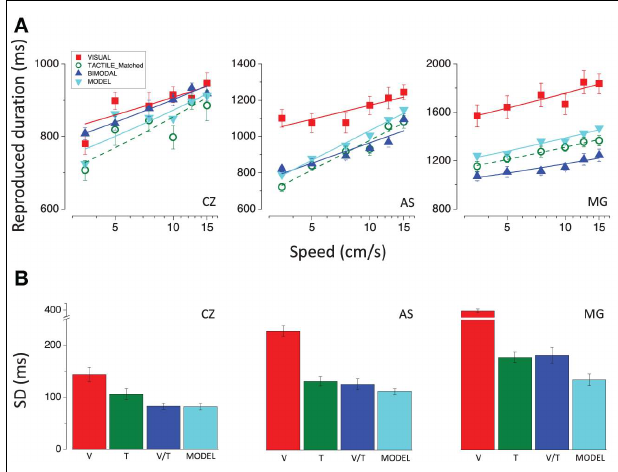
FIGURE 8 | (A) Reproduced durations as a function of speed relative to the 600ms stimuli.The green open symbols represent the reproduced durations for the tactile stimuli moving at the same perceived speed as the visual stimuli (red filled symbols). Blue symbols represent the results for the bimodal stimuli (visuo-tactile speed-matched stimuli) and the cyan symbols represent the results for the bimodal stimuli predicted according to Bayesian integration. (B) SDs of the reproduction averaged across speeds relative to the 600ms visual (red bar), tactile (green bar), and bimodal (blue bar) stimuli and predicted for bimodal stimuli according to the Bayesian model (cyan bar); results for all